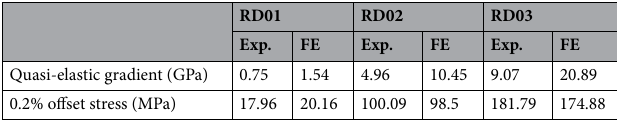
Table 3. Designed and manufactured relative densities.